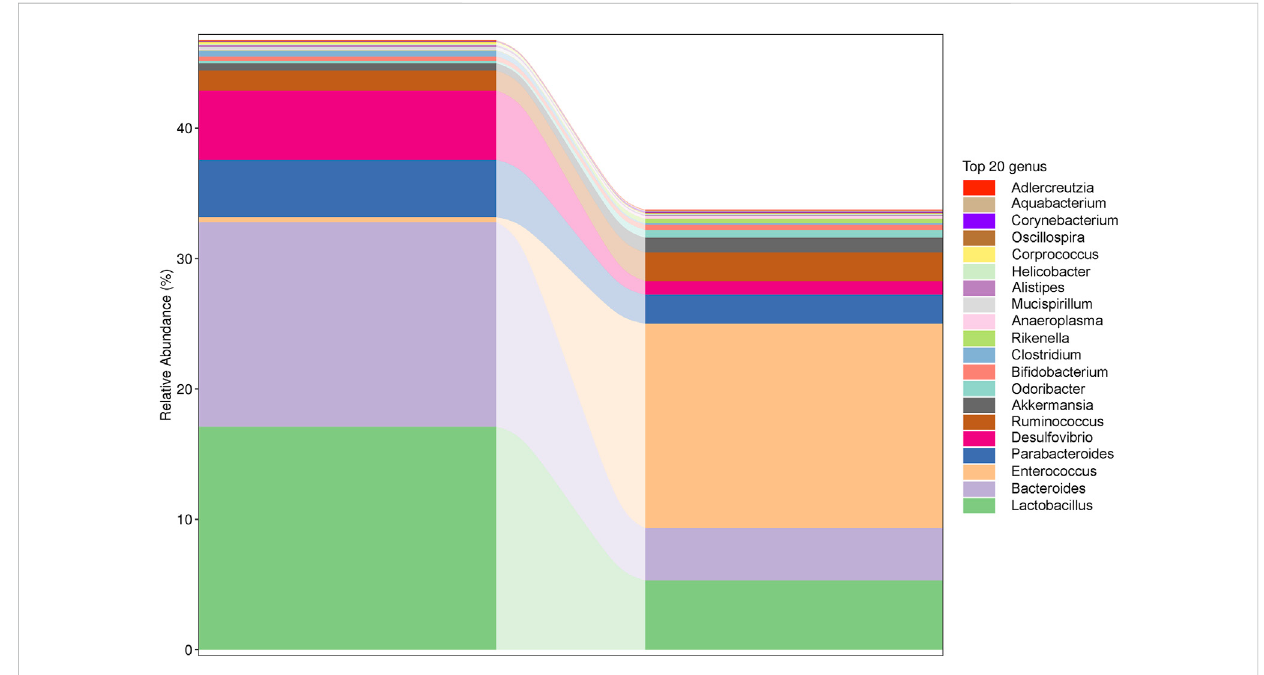
FIGURE 4 Changes in the relative abundance of the top 20 most signi fi cantly different